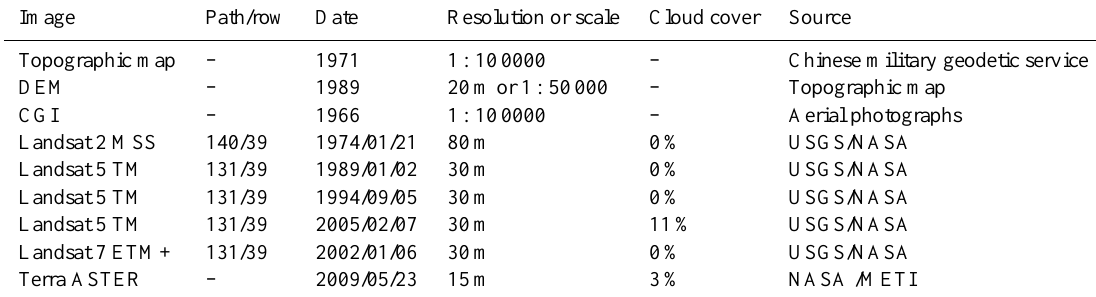
Table 1. Data sources used in this study. Image Path/row Date Resolution or scale Cloud cover Source Topographic